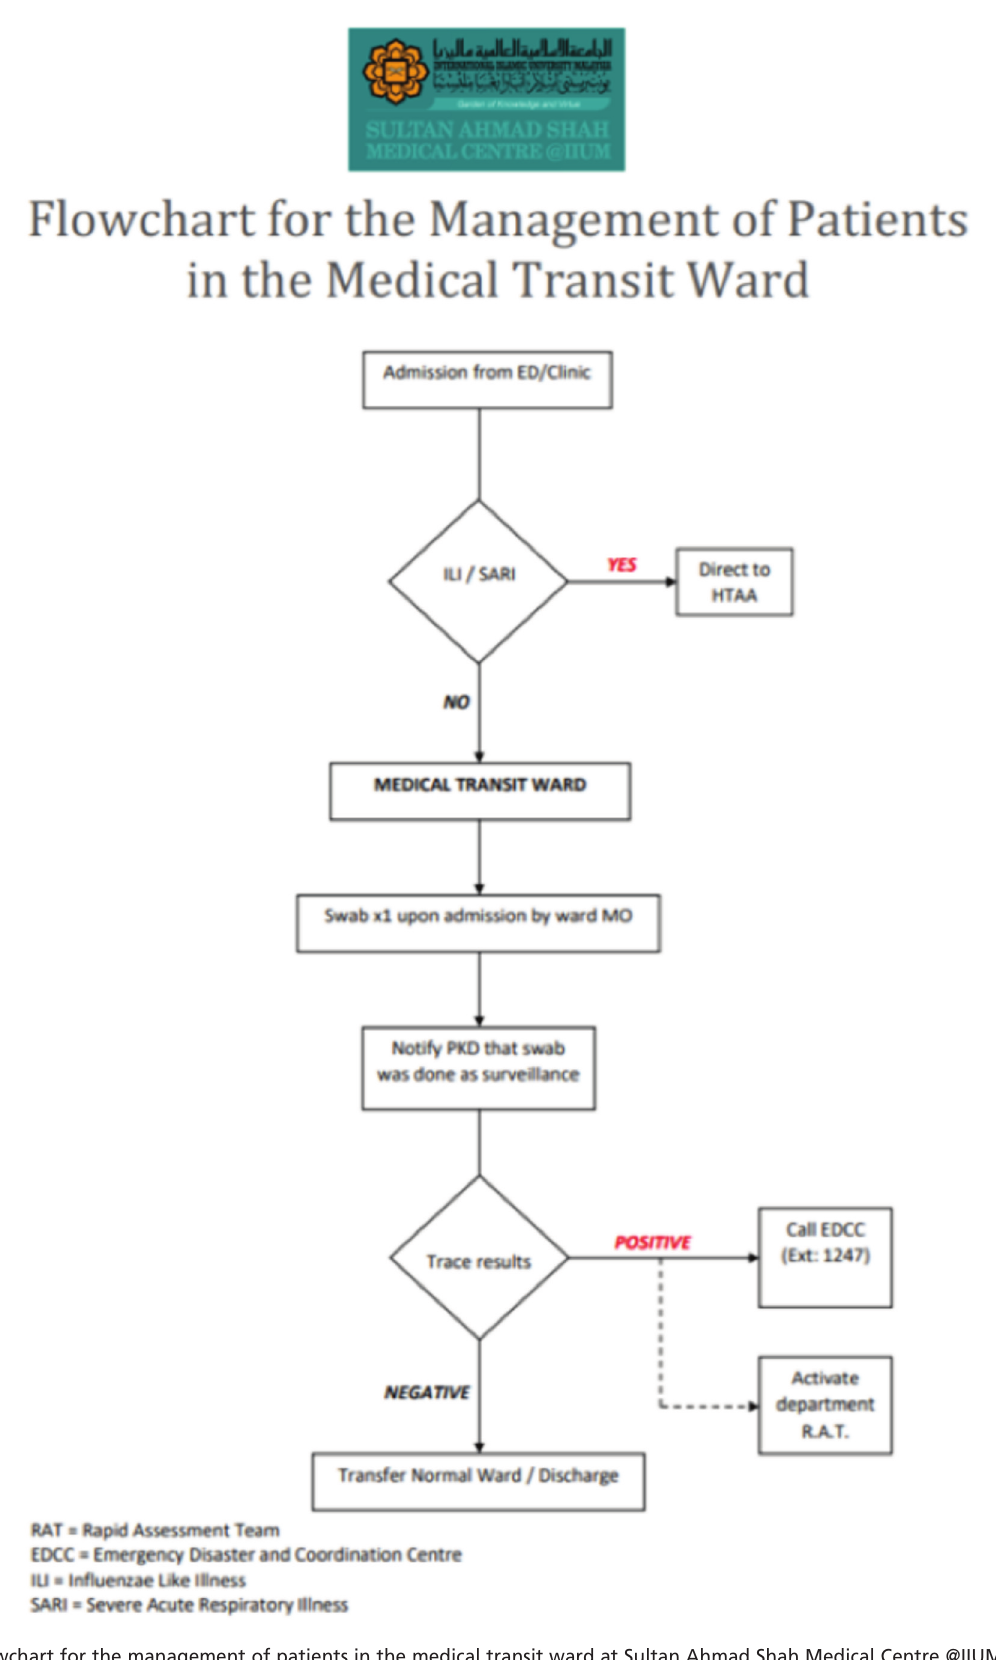
Flowchart for the management of patients in the medical transit ward at Sultan Ahmad Shah Medical Centre Fig. 5: